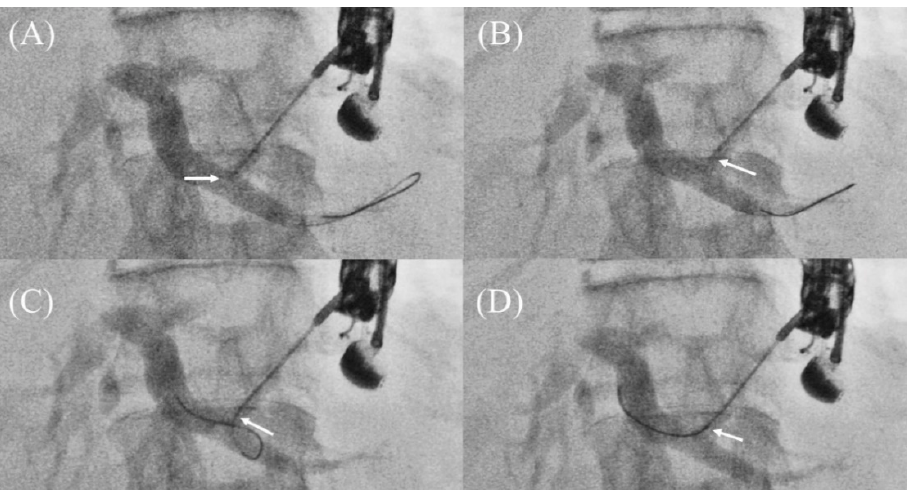
Figure 12. Liver impaction technique for redirection of a guidewire. If a guidewire is unintentionally advanced to the peripheral side ( A ), pull the needle tip slightly into the hepatic parenchyma ( B ). The guidewire can be pulled without shearing because the tip of the needle is covered by the hepatic parenchyma ( C ). The guidewire is successfully manipulated toward hilum ( D ). Arrows indicate the tip of the needle.